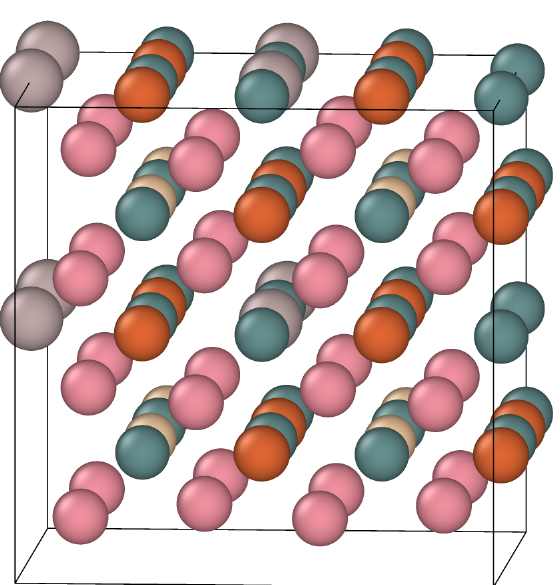
Figure 15. The 2 × 2 × 2 unit cells of the lowest enthalpy structure found by the GA, showing the positions of the cobalt (pink), aluminium (grey), germanium (turquoise), silicon (gold) and iron (orange)